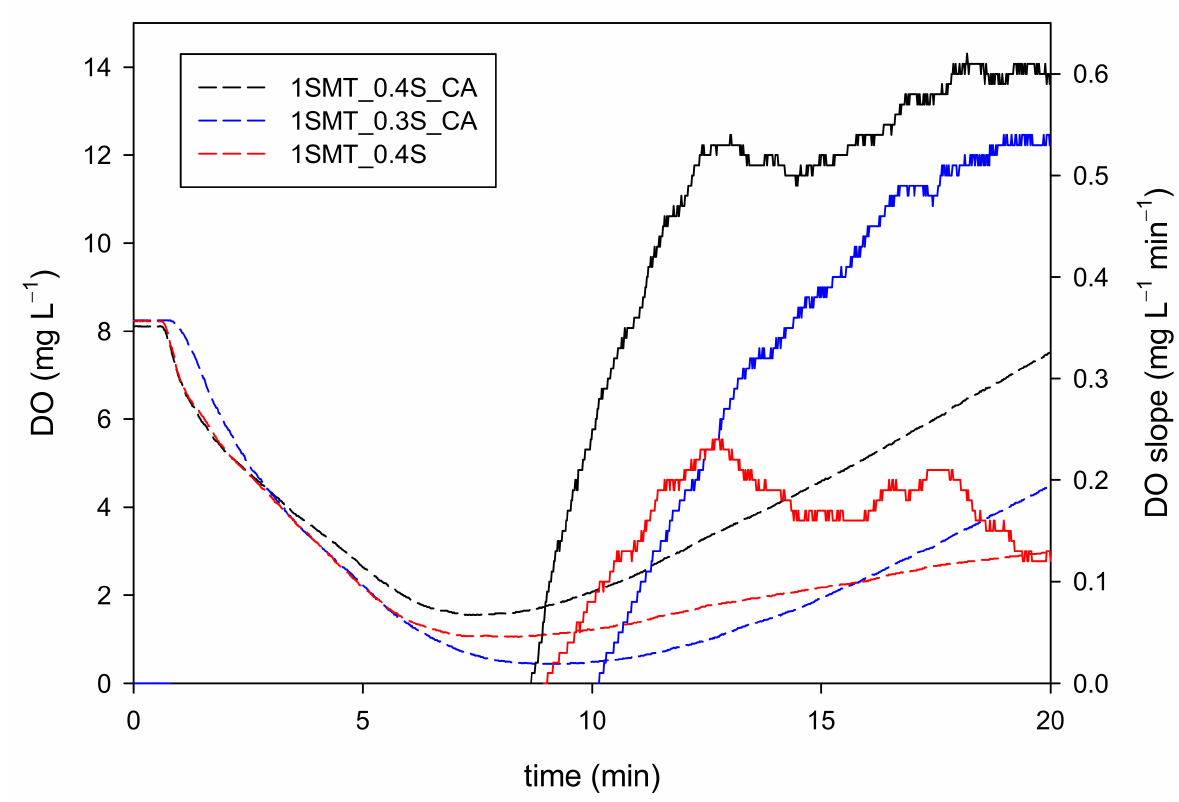
Figure 7. DO (dashed lines) and DO slope (lines) evolution profiles during the transition stage of SMT contaminated water treatment using 1SMT_0.4S_CA, 1SMT_0.3S_CA and 1SMT_0.4S dosage